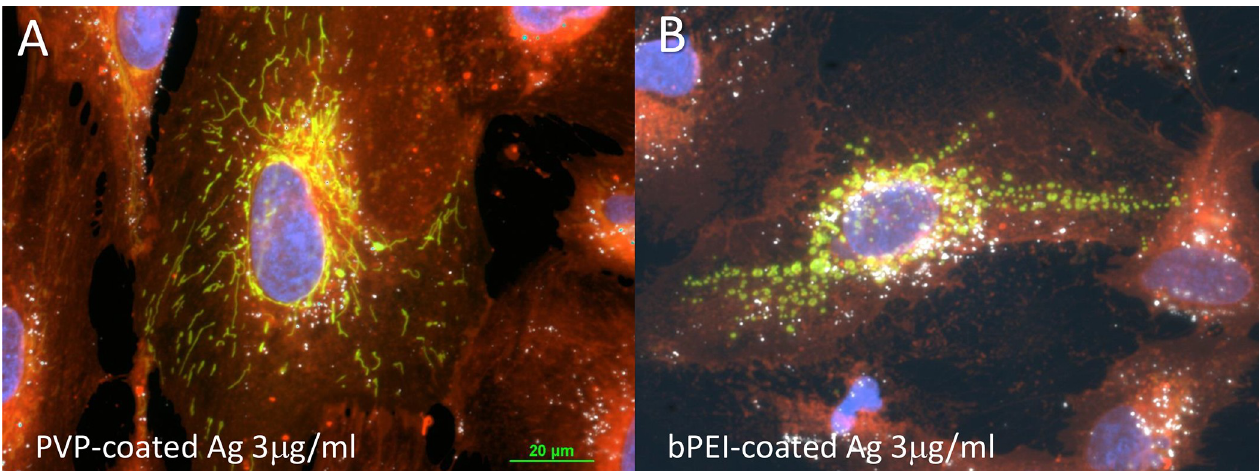
Fig 7. Mitochondria microscopy from AgNP-PVP and AgNP-bPEI treated cells. Comparison of the mitochondria shapes derived from cells treated with 3 μ g/ml of AgNP-PVP (Fig 7A) and AgNP-bPEI (Fig 7B). The AgNP-bPEI had beaded shapes while mitochondria derived from the AgNP-PVP treated cells had a linear strand like formation of mitochondria. The cytoplasm is stained with cell mask orange (designated by red), the mitochondria transfected with GFP (designated by green) and the nuclei are stained with DAPI (designated by blue). The NP (designated by white) are accumulated throughout the cytoplasm and around the nuclei with the AgNP-bPEI samples. Magnification